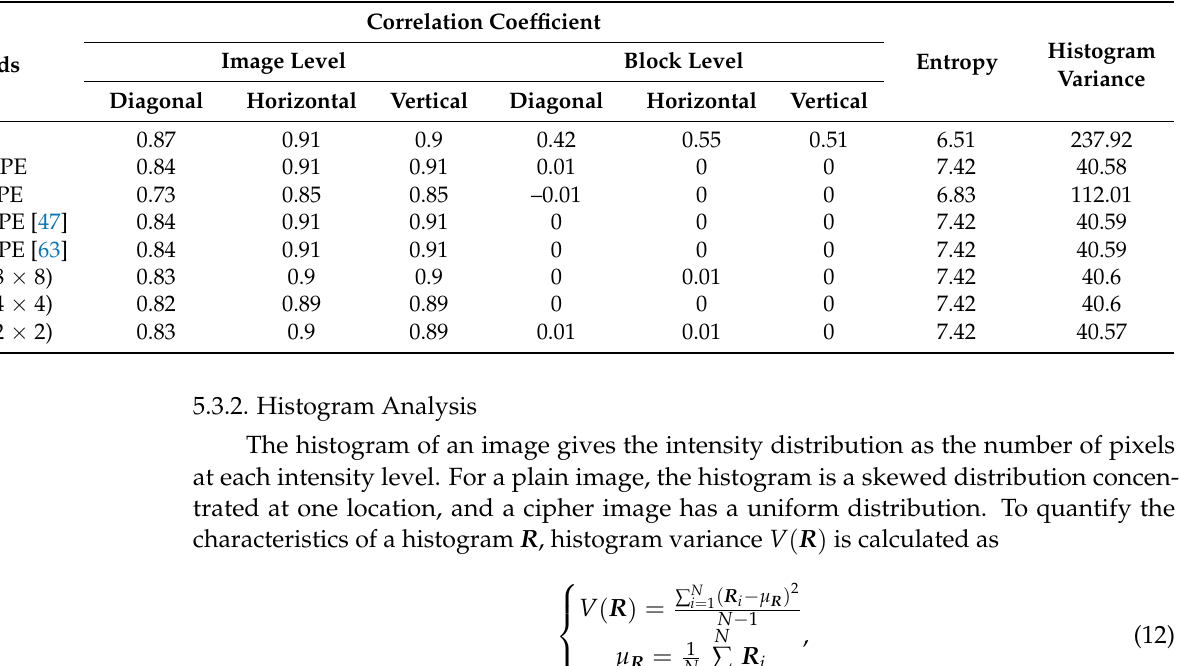
Table 7. The encryption analysis of the CPE schemes under different statistical